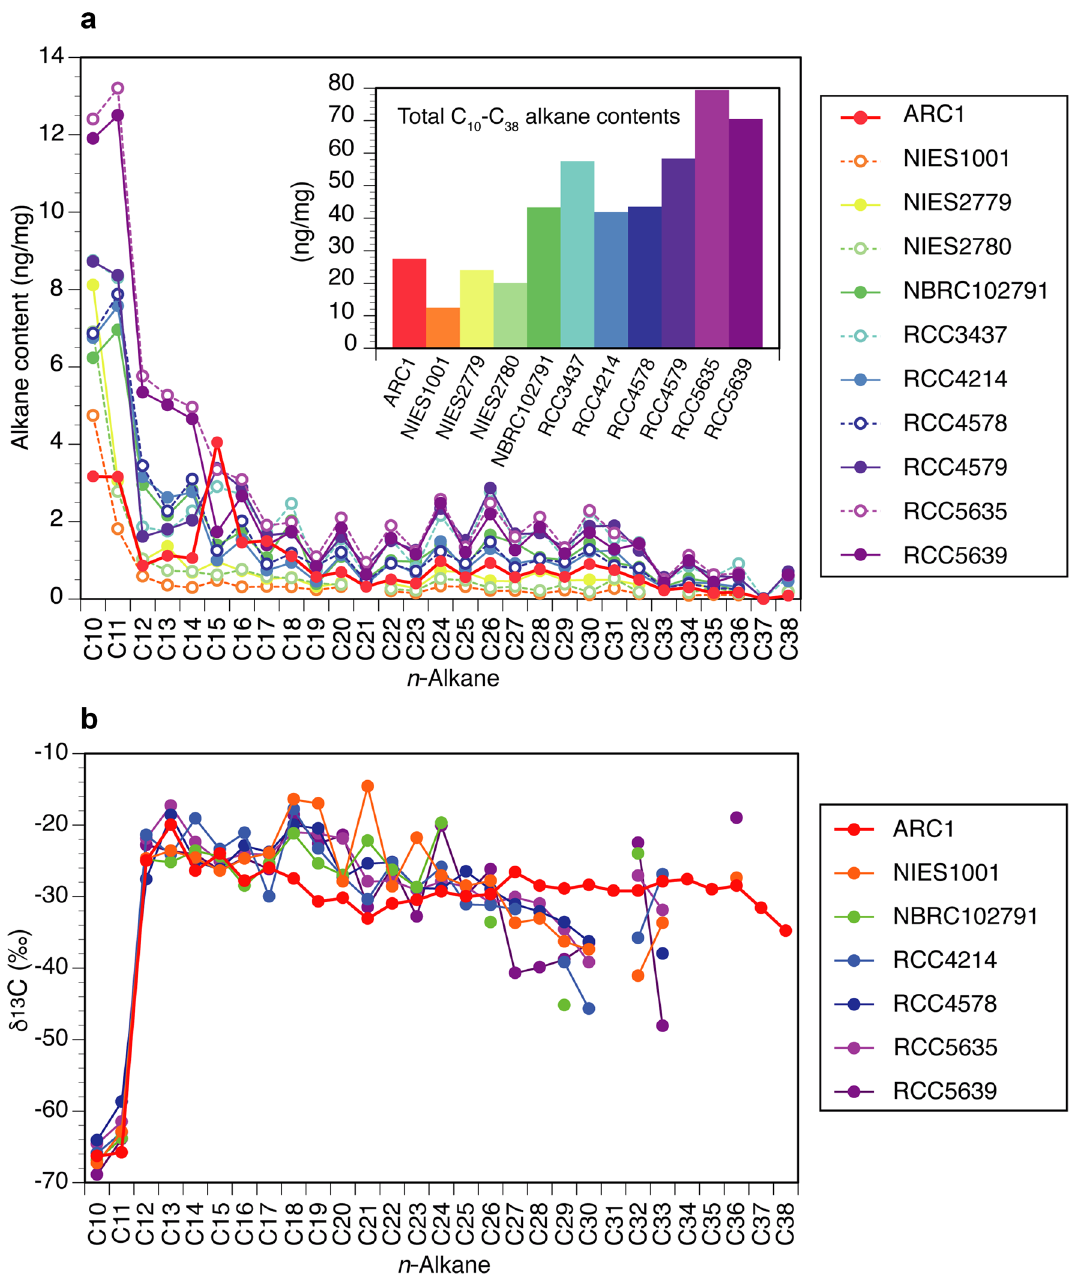
Figure 3. n -alkane concentrations and their compound-specific δ 13 C in the 11 Dicrateria strains. ( a ) Content of a series of n -alkanes, ng/mg cell dry weight and ( b) their compound-specific δ 13 C values in the ARC1 strain and 10 other Dicrateria strains collected from ocean sites throughout the world and stored in culture collections. Total amounts of the n -alkanes of each strain are shown in the inset bar